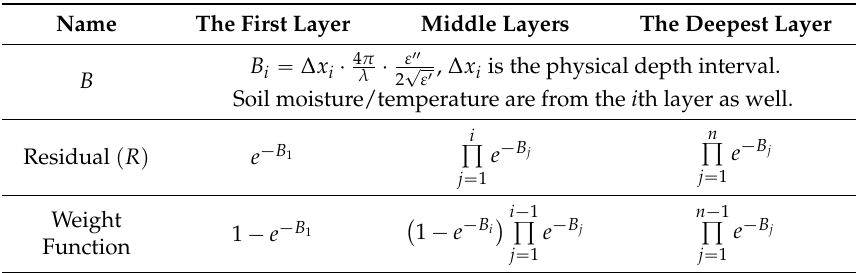
Table 1. The mathematical details regarding the concepts mentioned in this